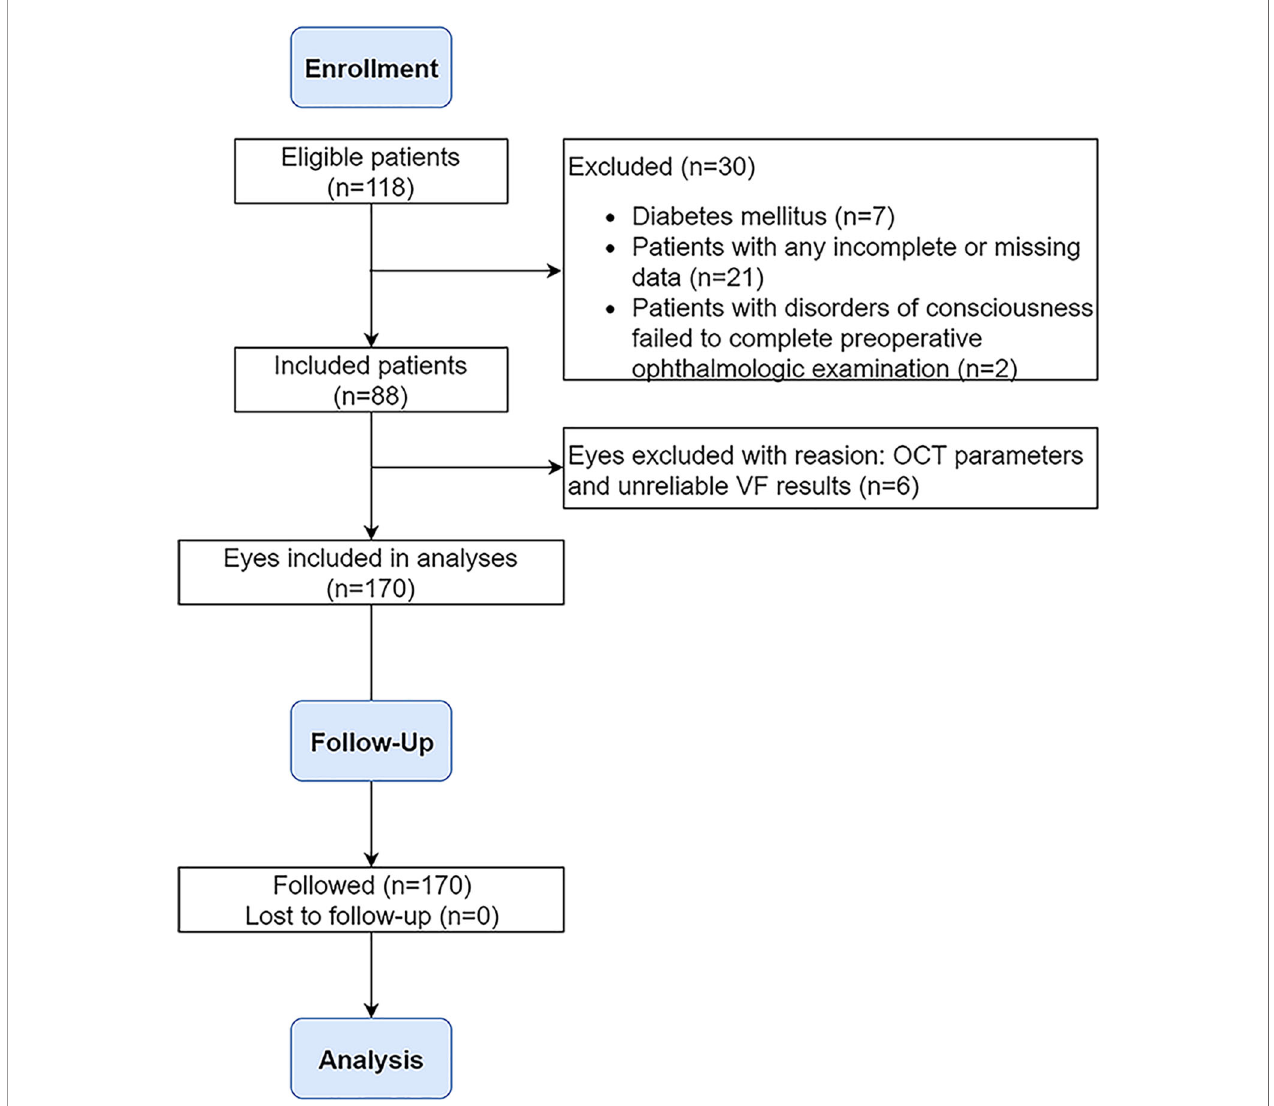
FIGURE 1 | Flowchart demonstrating the inclusion/exclusion criteria used in the selection process. OCT, optical coherence tomography; VF, visual fi